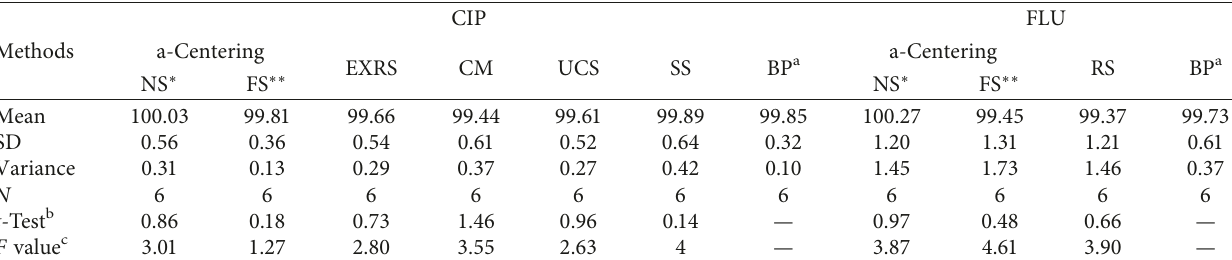
Table 4: Statistical comparison between the results obtained by the proposed spectrophotometric methods and official methods [6] for the determination of CIP and FLU in Otovel ® otic solution.